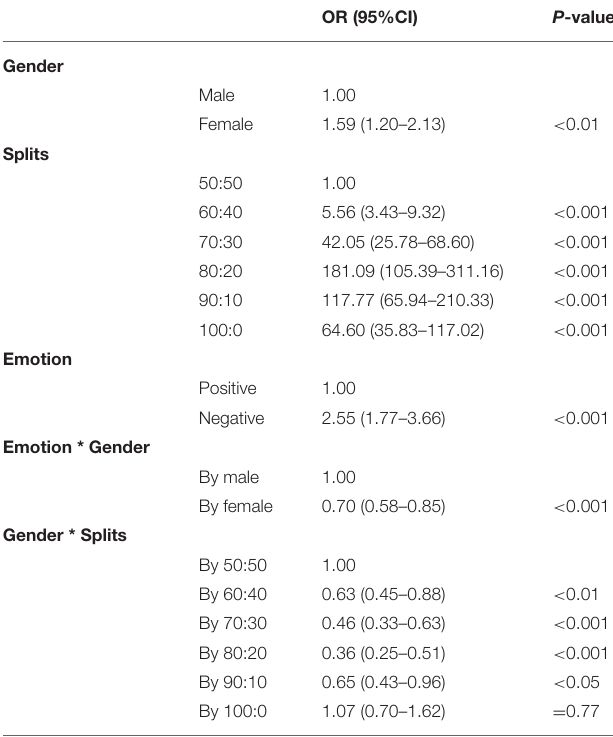
TABLE 2 | The logistic regressions analysis of punishments in Experiment